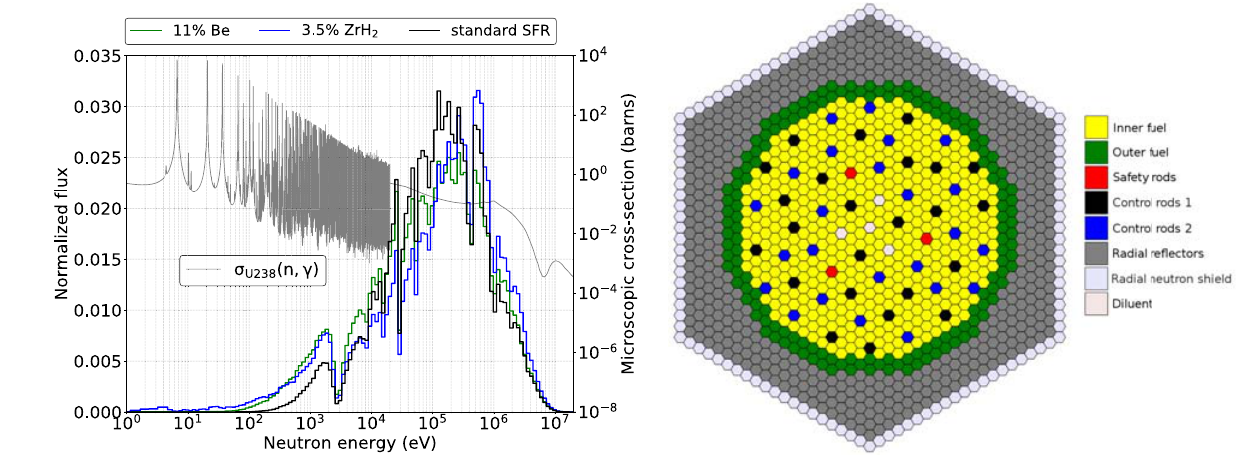
Figure 1: Neutron spectrum comparison for standard SFR and two CADOR